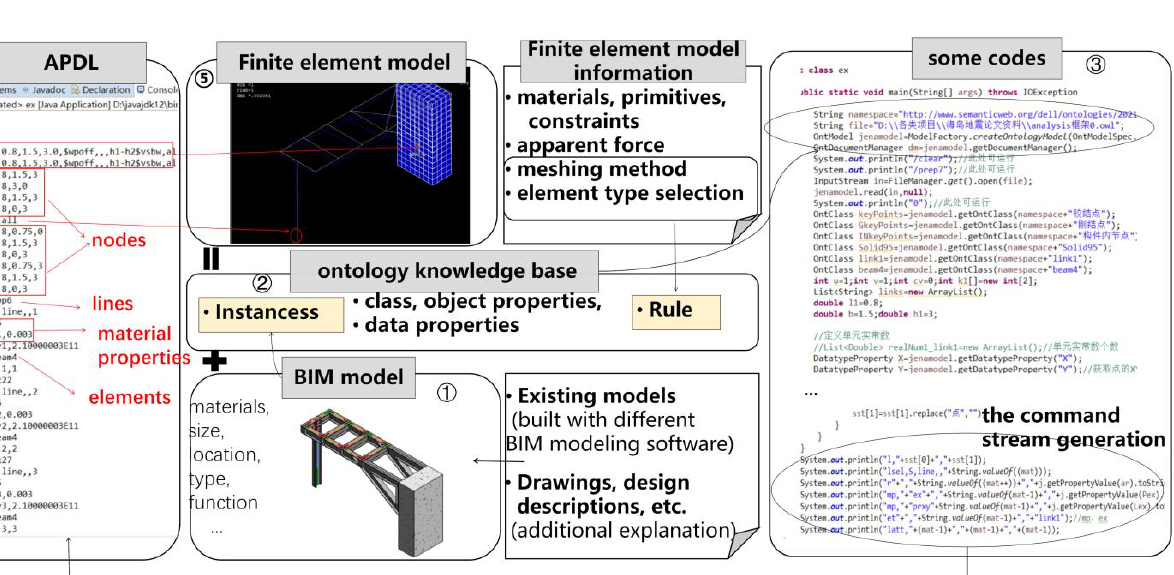
Figure 6. The process schematic of recording information of rod elements.